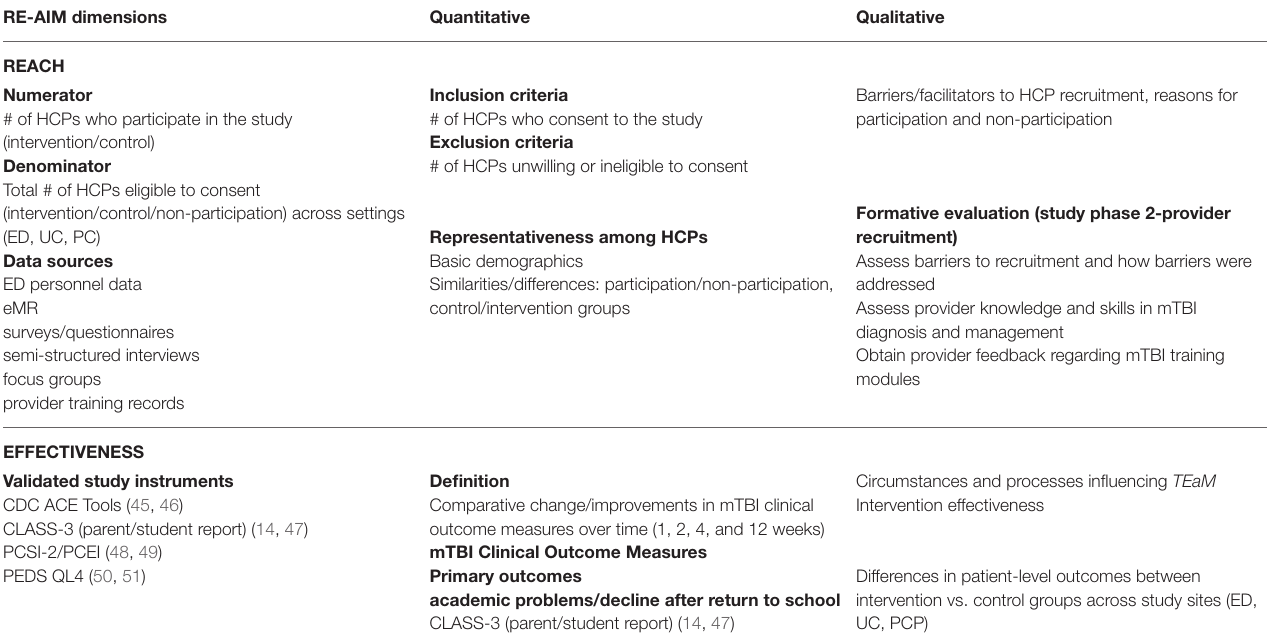
TABLE 1 | TEaM evaluation data collection